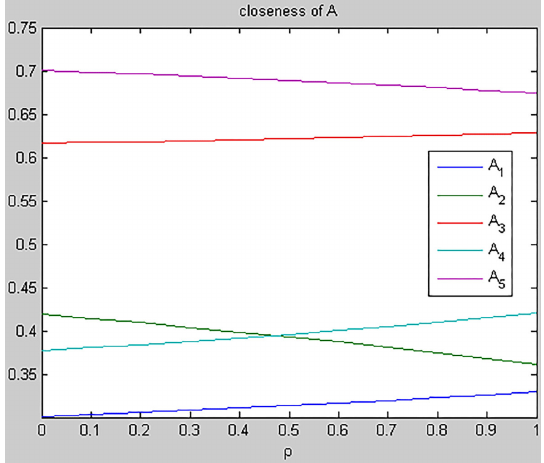
Fig. 1. The results of HFOWAWAD-TOPSIS under different values of